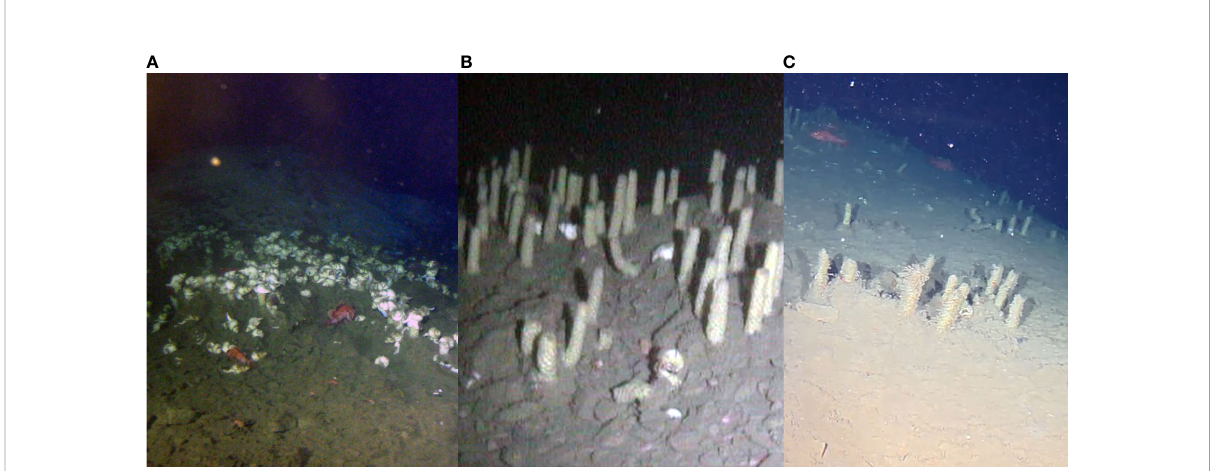
FIGURE 2 Egg towers of buccinid snails, located between two hydrate mounds. (A) Snail aggregation covering the sea fl oor from the point at which bacterial mats were visible on the hydrate mound, and down the fl ank (image taken on April 22 2014). (B) Fully developed and dense egg towers, with only a handful of snails present (image taken on November 06 2014). (C) Remnants of the tower fi eld (image taken on August 31 2021). Note the patchy distribution, as well as the varying decaying state of some of the